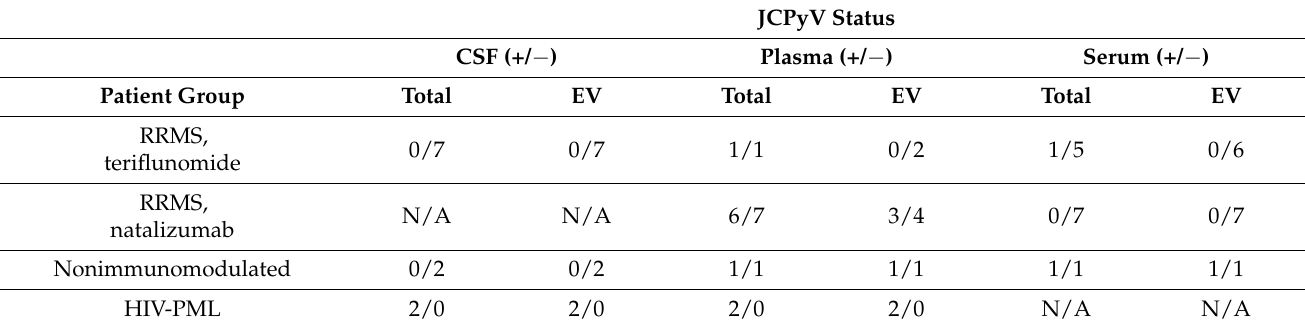
Table 1. JCPyV was detected in plasma and serum of one nonimmunomodulated patient and in plasma from three of seven natalizumab-treated patients in the EV fraction; six of seven patients were positive for JCPyV when the total sample was analyzed. JCPyV was not detected in any RRMS CSF samples and was not detected in plasma- or serum-derived EV from teriflunomide-treated patients; one plasma and one serum as total sample were JCPyV positive. PML control patients were positive for JCPyV in plasma and CSF, both in total and EV fractions. N/A indicates the sample was not available for